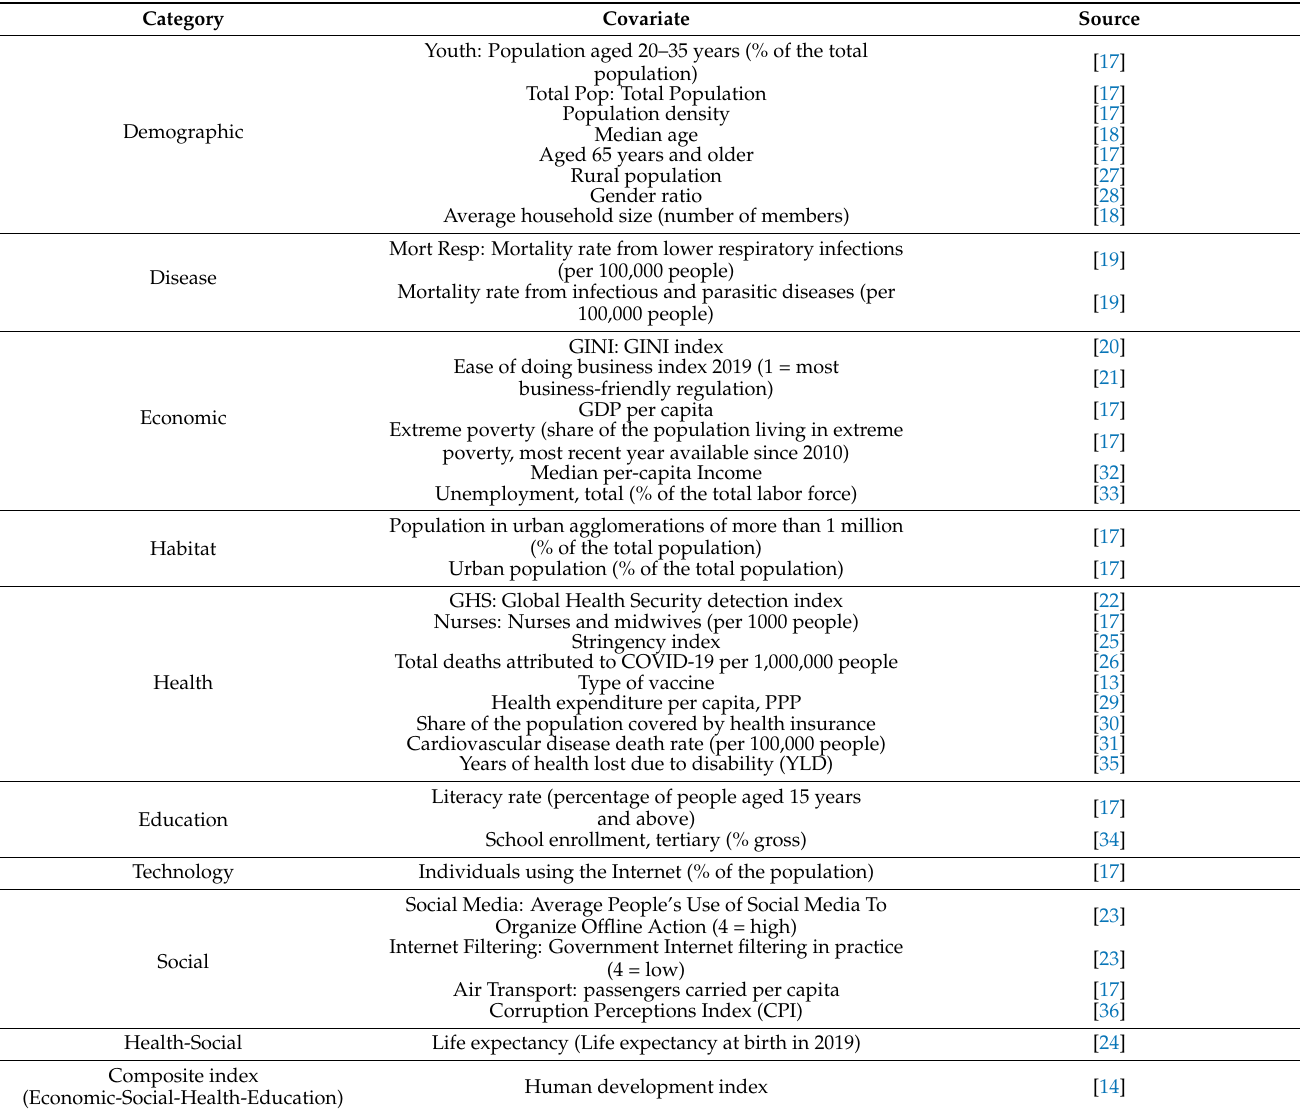
Table 1. List of all the covariates used in this study with their explanations and